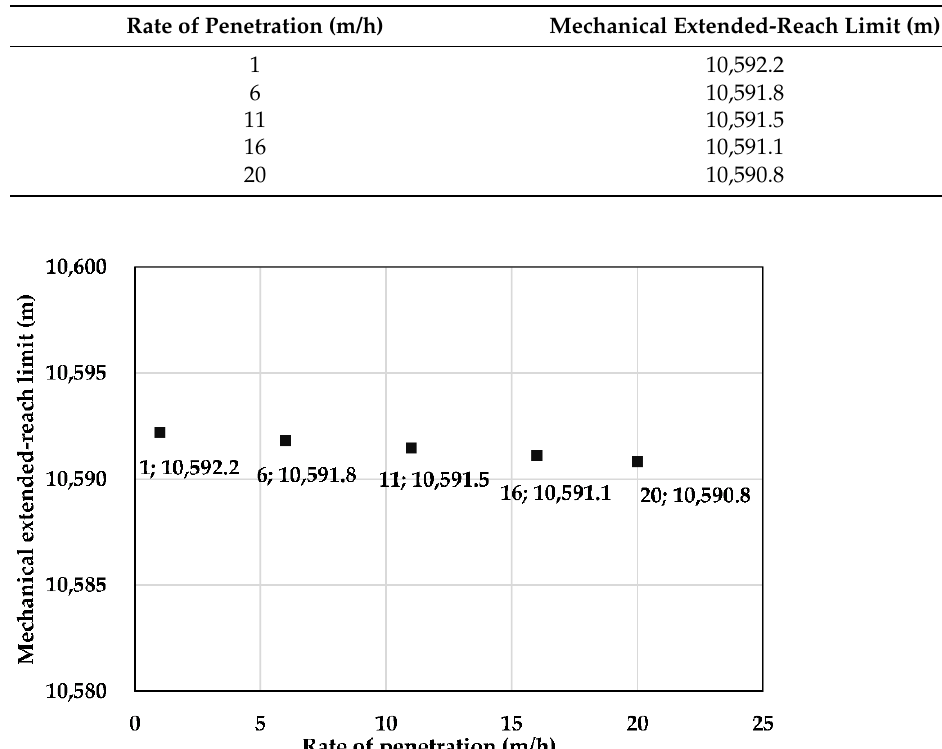
Figure 11. Effect of the weight on bit on the mechanical extended-reach limit. Table 10. Mechanical extended-reach limits with different rates of penetration.